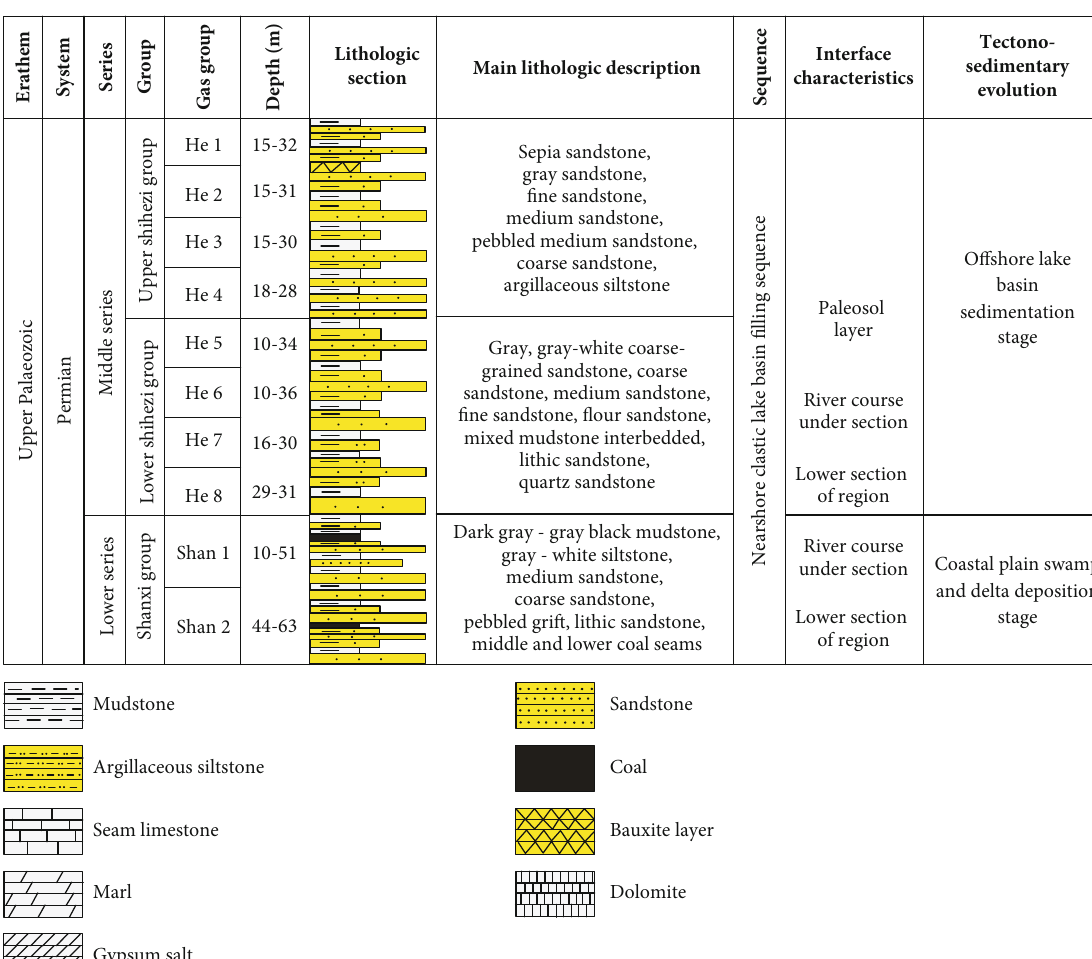
Figure 2: Lithological histogram of Shihezi Group and Shanxi Group in the study area